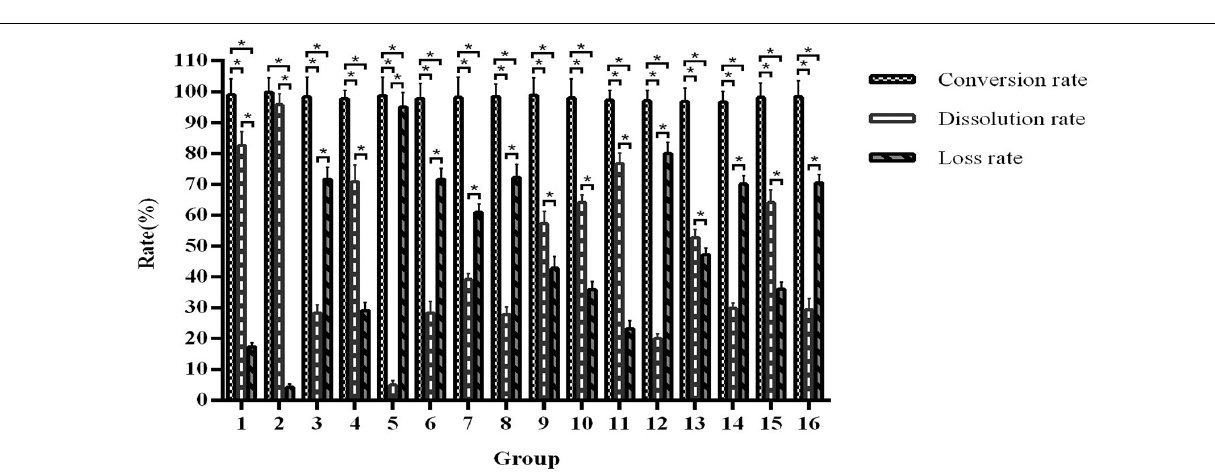
FIGURE 8 | Orthogonal optimisation of fermentation conditions. *Indicates significance at the 0.01 level.